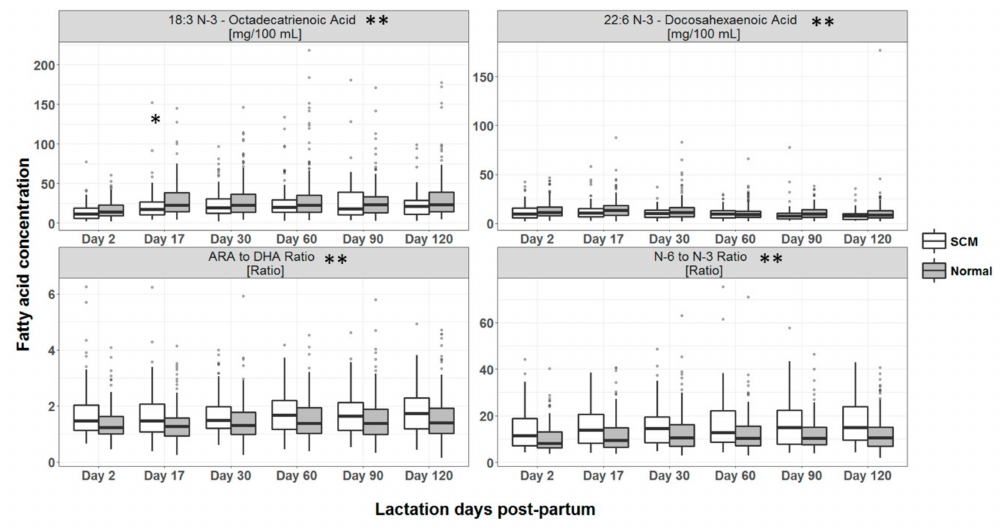
Figure 4. Concentrations of fatty acids in HM across lactation by presence or absence of SCM. * Statistical significance of the di ff erence between mothers with SCM and without SCM for a particular time point with p value < 0.05, ** p value for overall di ff erence between groups <